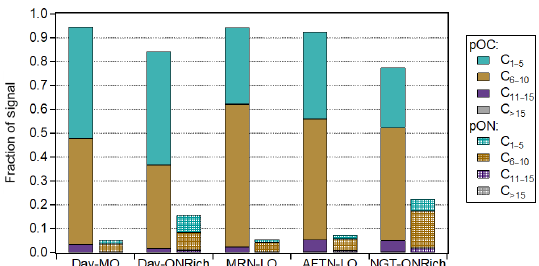
Figure 5. Fraction of pOC and pON ions of different carbon num- bers (grouped as C 1–5 , C 6–10 , C 11–15 , and C > 15 ) in each FI- GAERO OA